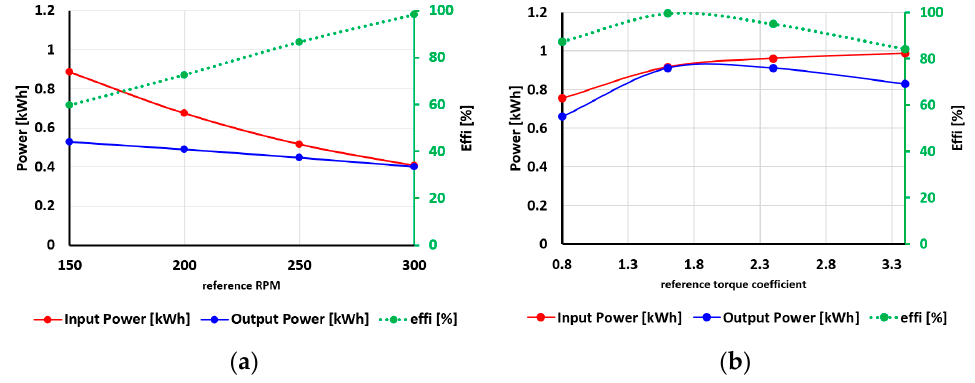
Figure 24. Input and output power generation and PTO system efficiency according to ( a ) speed control algorithm and ( b ) optimal torque control algorithm under the same irregular wave input conditions ( H s = 0.75 m, T p = 4.75 s).